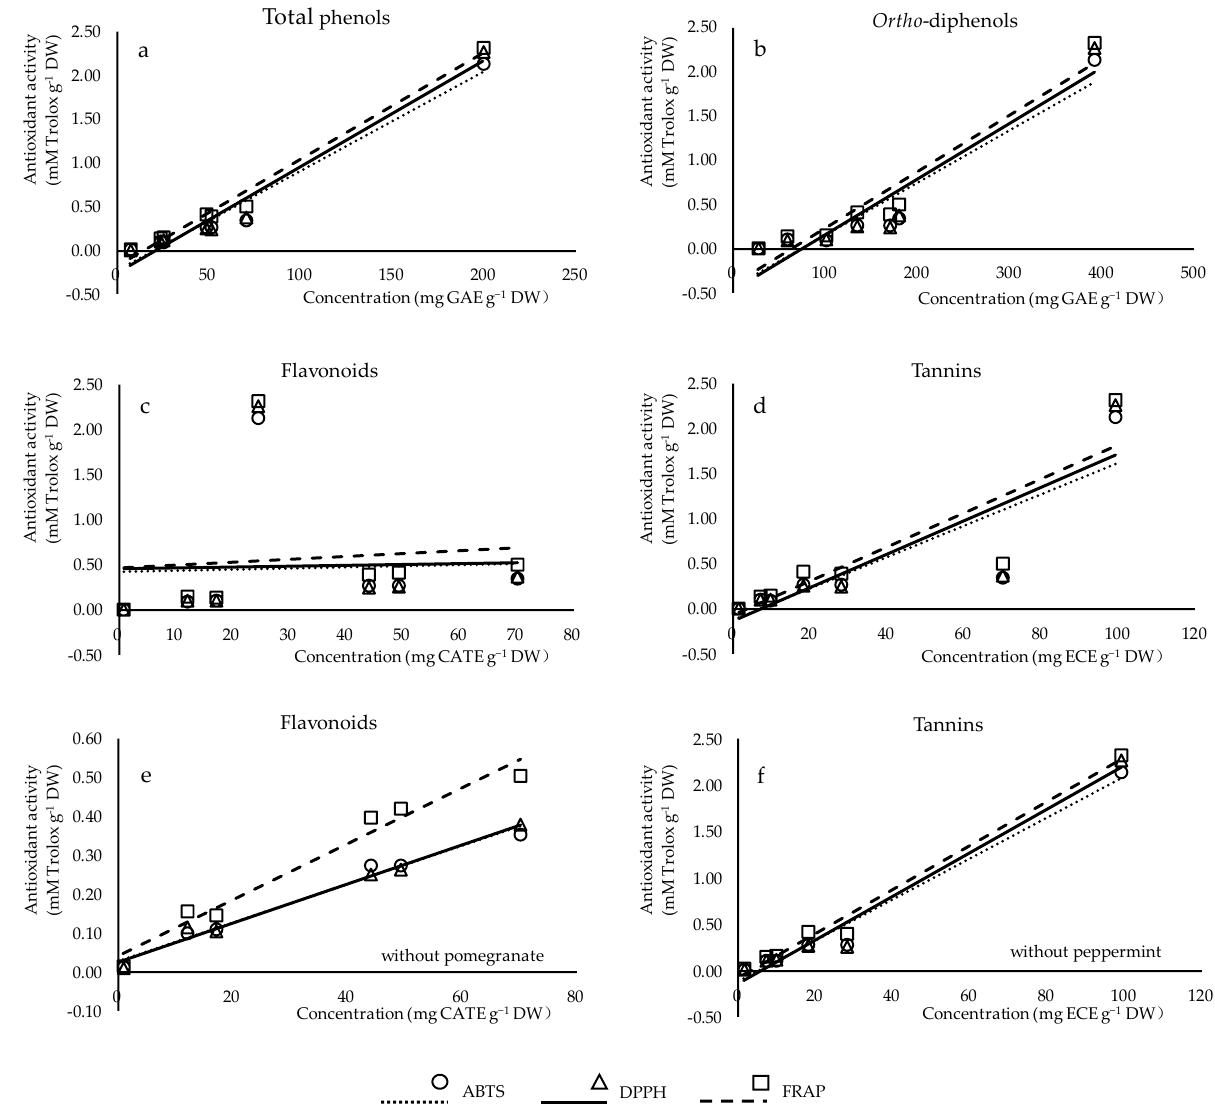
Figure 1. Correlation analysis between the contents of phenolic classes (x-axis) and antioxidant capacities (y-axis) measured by ABTS (circles), DPPH (triangles), and FRAP (squares). ( a – d ) The correlation of total phenols ( r ABTS , DPPH , FRAP = 0.985***, 0.984***, 0.993***), ortho -diphenols ( r ABTS , DPPH , FRAP = 0.859*, 0.861*, 0.878**), flavonoids ( r ABTS , DPPH , FRAP = 0.038, 0.031, 0.098), and tannins ( r ABTS , DPPH , FRAP = 0.859*, 0.861*, 0.878**) of the studied plants with their antioxidant activity, respectively. ( e ) The correlation of flavonoids ( r ABTS , DPPH , FRAP = 0.989***, 0.992***, 0.983***) of studied plants excluding pomegranate with their antioxidant activity. ( f ) The correlation of tannins of studied plants excluding peppermint ( r ABTS , DPPH , FRAP = 0.989***, 0.987***, 0.993***) with their antioxidant